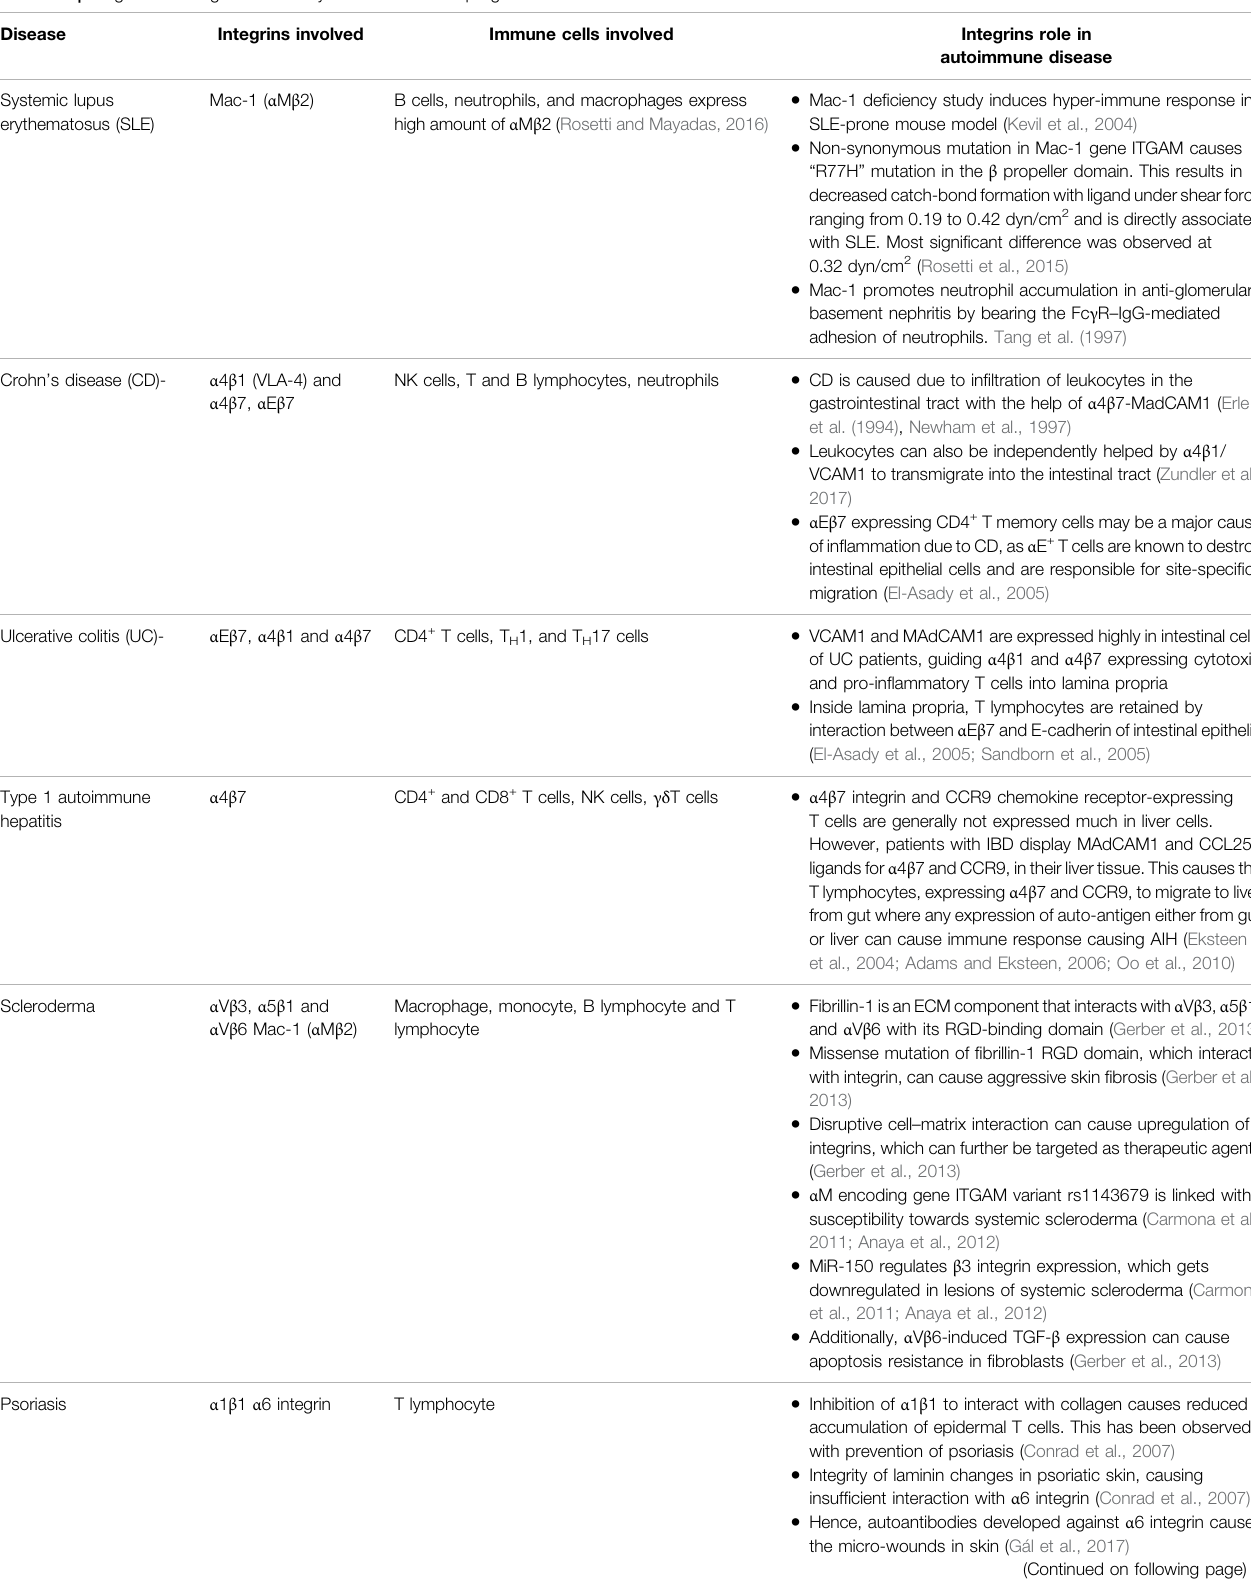
TABLE 3 | Integrin and its ligands as a key contributor in the progression of autoimmune diseases